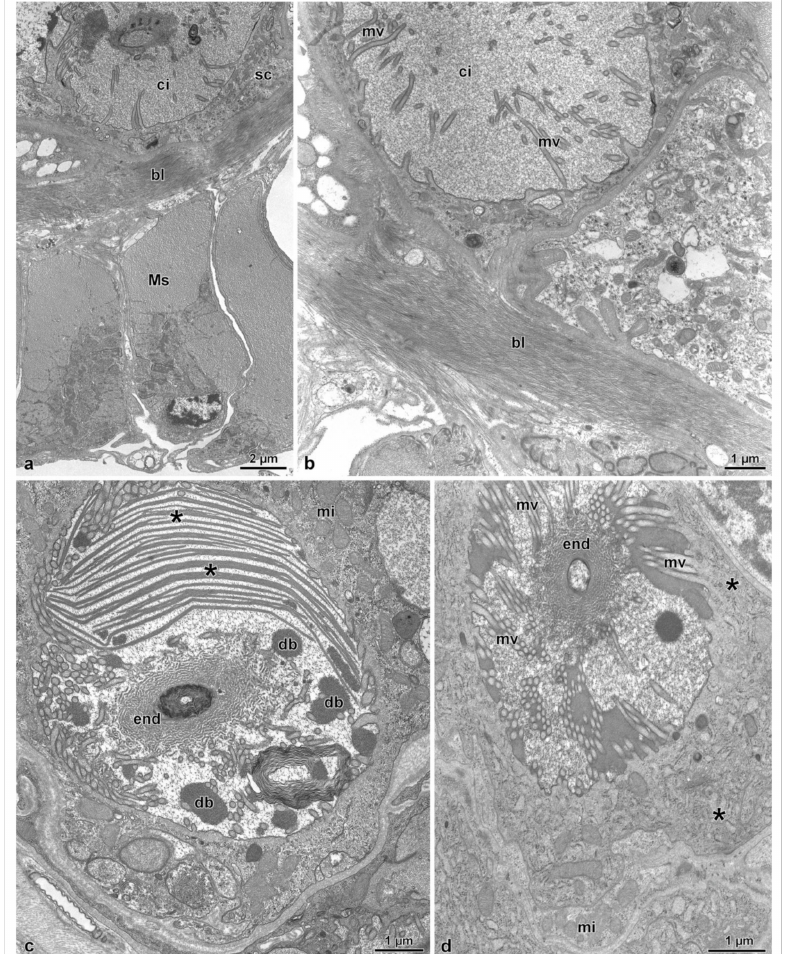
Figure 4. ( a ). Cross section through the basal epithelial region of the spermathecal gland. Note the secretory cell (sc) with the cistern (ci). Beneath the epithelium, a fibrous basal lamina (bl) and a thick layer of muscle cells (Ms) are visible. ( b ). Cross section of a secretory cell showing a large cistern (ci) lined by long microvilli (mv). ( c ). Cross section through a cistern of a secretory cell with the lumen filled with numerous laminar structures (asterisks) and dense bodies (db). In the center of the cistern, the “end apparatus” (end) of a duct of the duct-forming cell is visible. In the cytoplasm, mitochondria (mi) and few cisterns of rough endoplasmic reticulum are present. ( d ). Cross section through a cistern of a secretory cell. Note the long microvilli (mv) and the “end apparatus” (end). Note the mitochondria (mi) and the few cisterns of rough endoplasmic reticulum